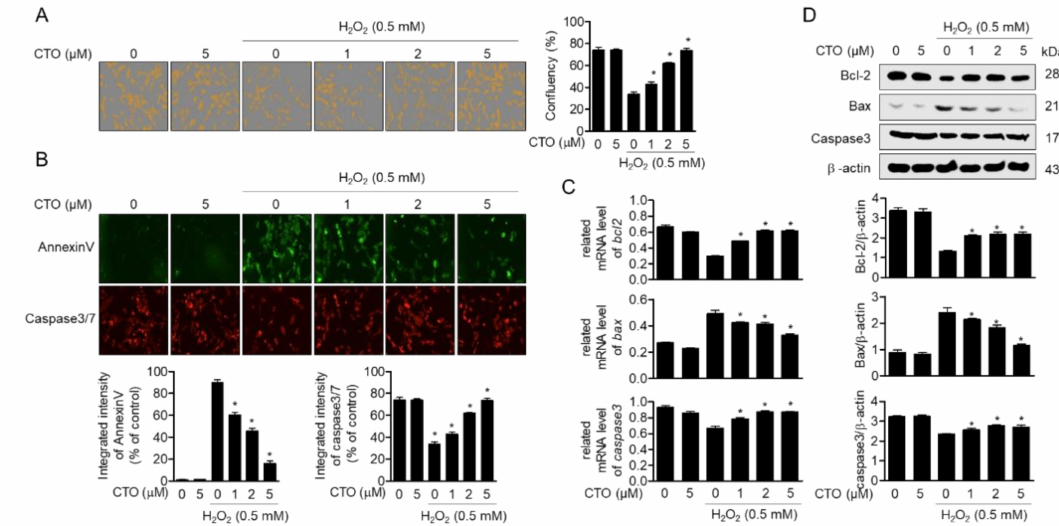
Figure 5. CTO inhibits the apoptotic pathway induced by treatment with H 2 O 2 in SW1353 cells. ( A , B ) The cells were pre-treated with or without the indicated concentration of CTO (0, 1, 2, and 5 µ M) for 6 h and then incubated with 0.5 mM H 2 O 2 for 2 h. The confluency of cells was measured by IncuCyte imaging system ( A ), and apoptotic cells were evaluated by staining with Annexin V and caspase-3 / 7 ( B ). ( C , D ) The mRNA levels of bcl-2 , bax and caspase3 were measured by real-time PCR ( C ) and protein expressions were confirmed by Western blot analysis ( D ). The results were normalized to gapdh ( C ) or β –actin ( D ) expression. * p < 0.05 was considered significant compared to only H 2 O 2 treat